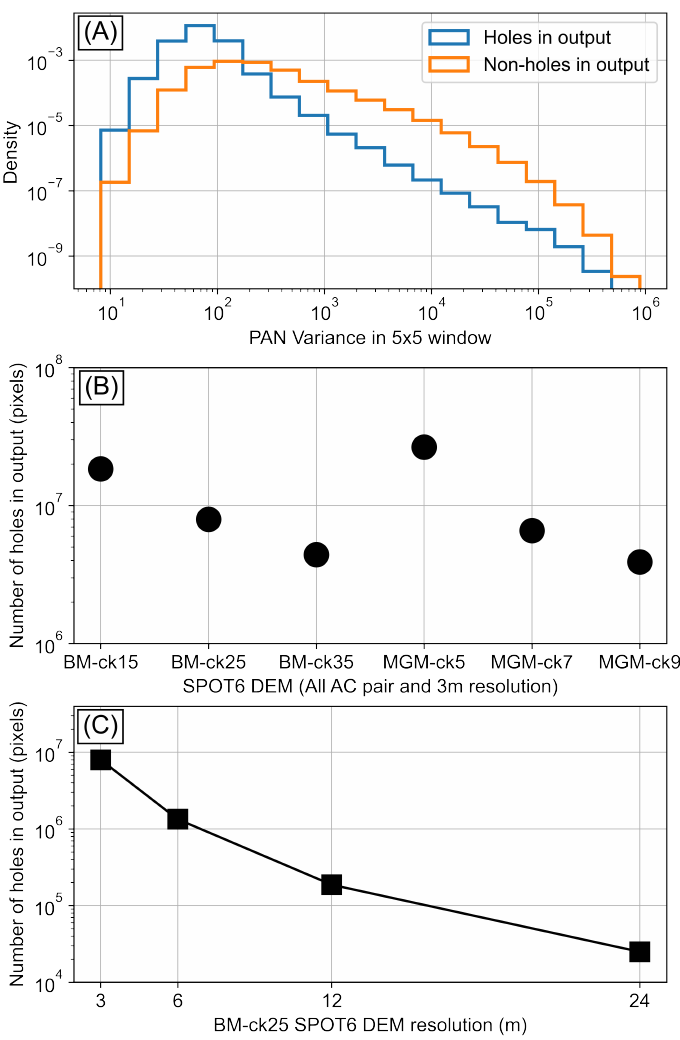
Figure 5. ( A ) Comparison of PAN variance in DEM pixels with elevation values versus no-data holes (shown here for the BM-ck25 3 m DEM); ( B ) holes in output DEM for each of the 3 m DEMs generated from the AC image pair (cf. Table 1); ( C ) holes in output DEM for the BM-ck25 at 3, 6, 12, and 24 m resolution, which is 2, 4, 8, and 16 × the input PAN image resolution,